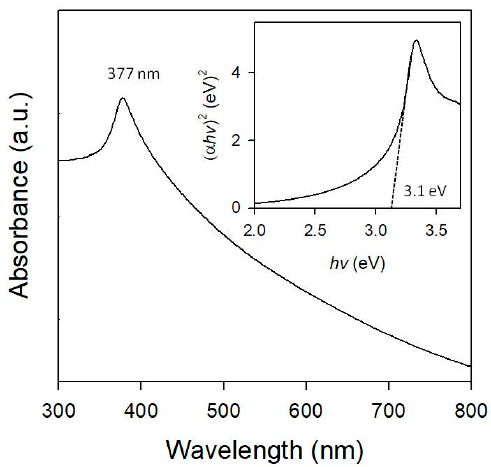
Figure 5. The UV-Vis absorption spectrum at room-temperature of Au/ZnO synthesized in a micro-reactor. Inset of ( α hv) 2 (eV) 2 vs. photon energy (hv).